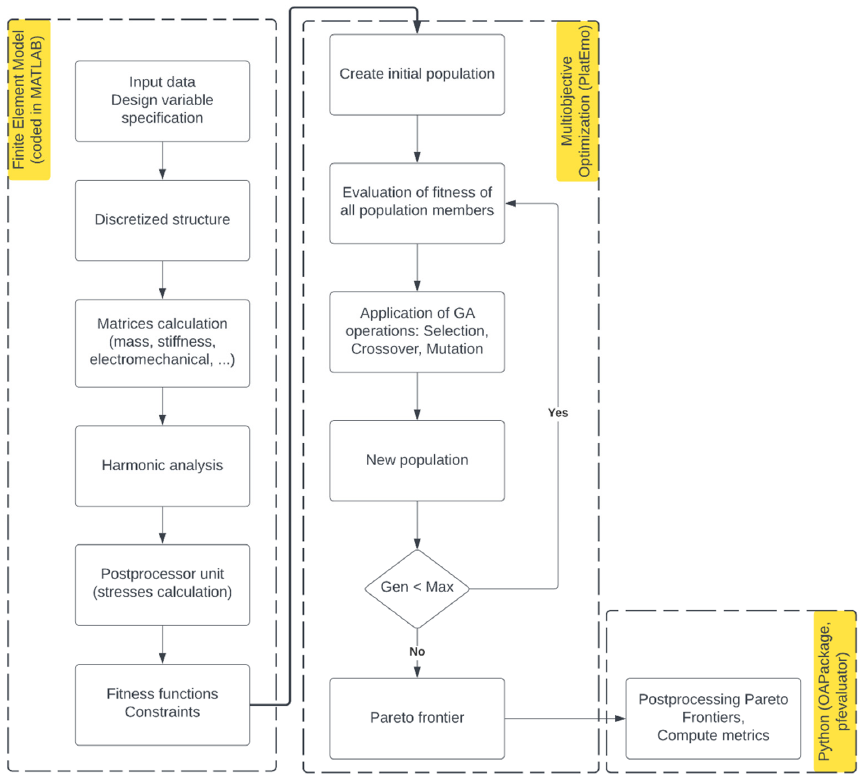
Figure 3. Flowchart of the optimization procedure.